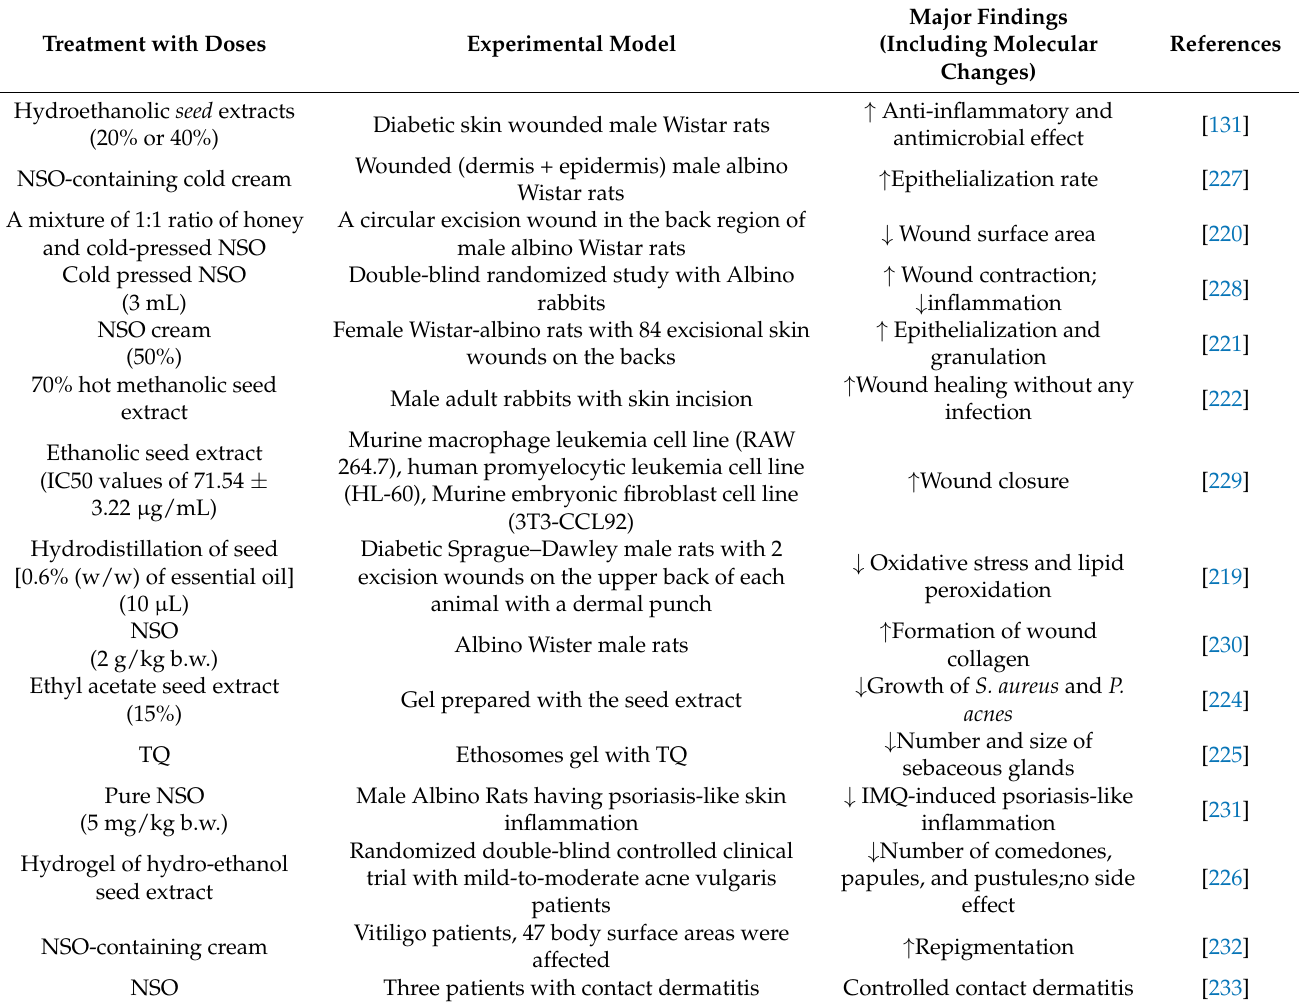
Table 9. Comprehensive summary on the skin protective effects of black